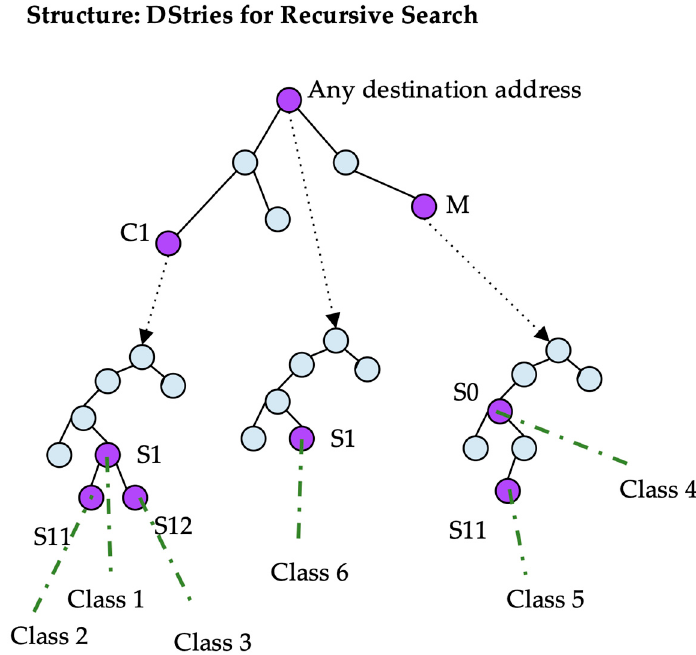
Figure 5. DStrie for recursive search example.